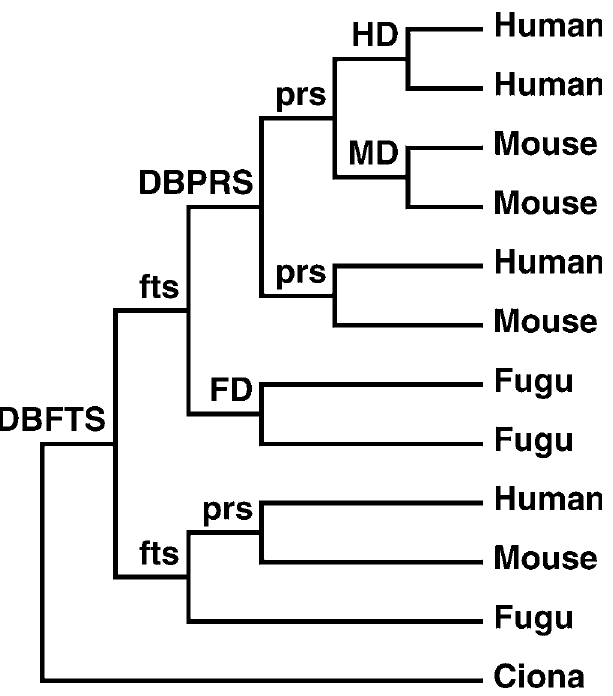
Figure 3. Hypothetical Phylogenetic Tree Showing All Possible Types of Gene Relationships and How They Are Most Parsimoniously Interpreted Interior nodes are designated in lower case for those that simply result from lineage splitting and in upper case for gene duplications within a lineage. Although not shown, nodes are still scored if there is gene loss. Phylogenetic trees for each gene family can be viewed at http://phigs. org/, also providing a valuable tool for improving the inference of gene function. DBFTS, duplication before fish–tetrapod split; DBPRS, duplica- tion before primate–rodent split; FD, fugu duplication; fts, fish–tetrapod split; HD, human duplication; MD, mouse duplication; prs, primate– rodent split. DOI: 10.1371/journal.pbio.0030314.g003